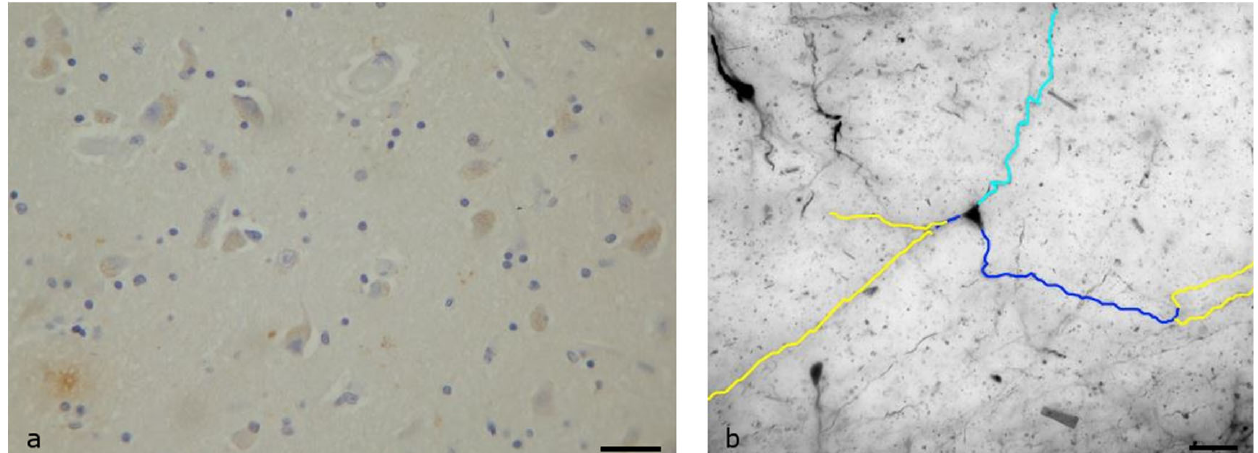
Figure 4. Ventromedial nucleus of the human Hypothalamus: ( a ) Immunohistochemical staining, specific for OX1R. More than 70% of both types of neurons were immunopositive in OX1R, but the stain was less intense for the smaller neurons (Scale bar, 30 μ m); ( b ) A Golgi-stained neuron of the compact compartment, mapped by the ImageJ program. Only primary (dark blue) and secondary (yellow) dendrites can be found. Light blue depicts the axon of the neuron (Scale bar, 20 μ m). The main neurons had, on average, two primary dendrites, with a mean total length of 244 µ m, and three secondary dendrites, with a mean total length of 502 µ m. Only 5 of the 27 neurons that were observed had tertiary dendrites. Quaternary and quinary dendrites were not found in any neuron (Figure 4b). Sholl analysis of the dendrites revealed that the dendrites displayed higher densities near the cell body (40 µ